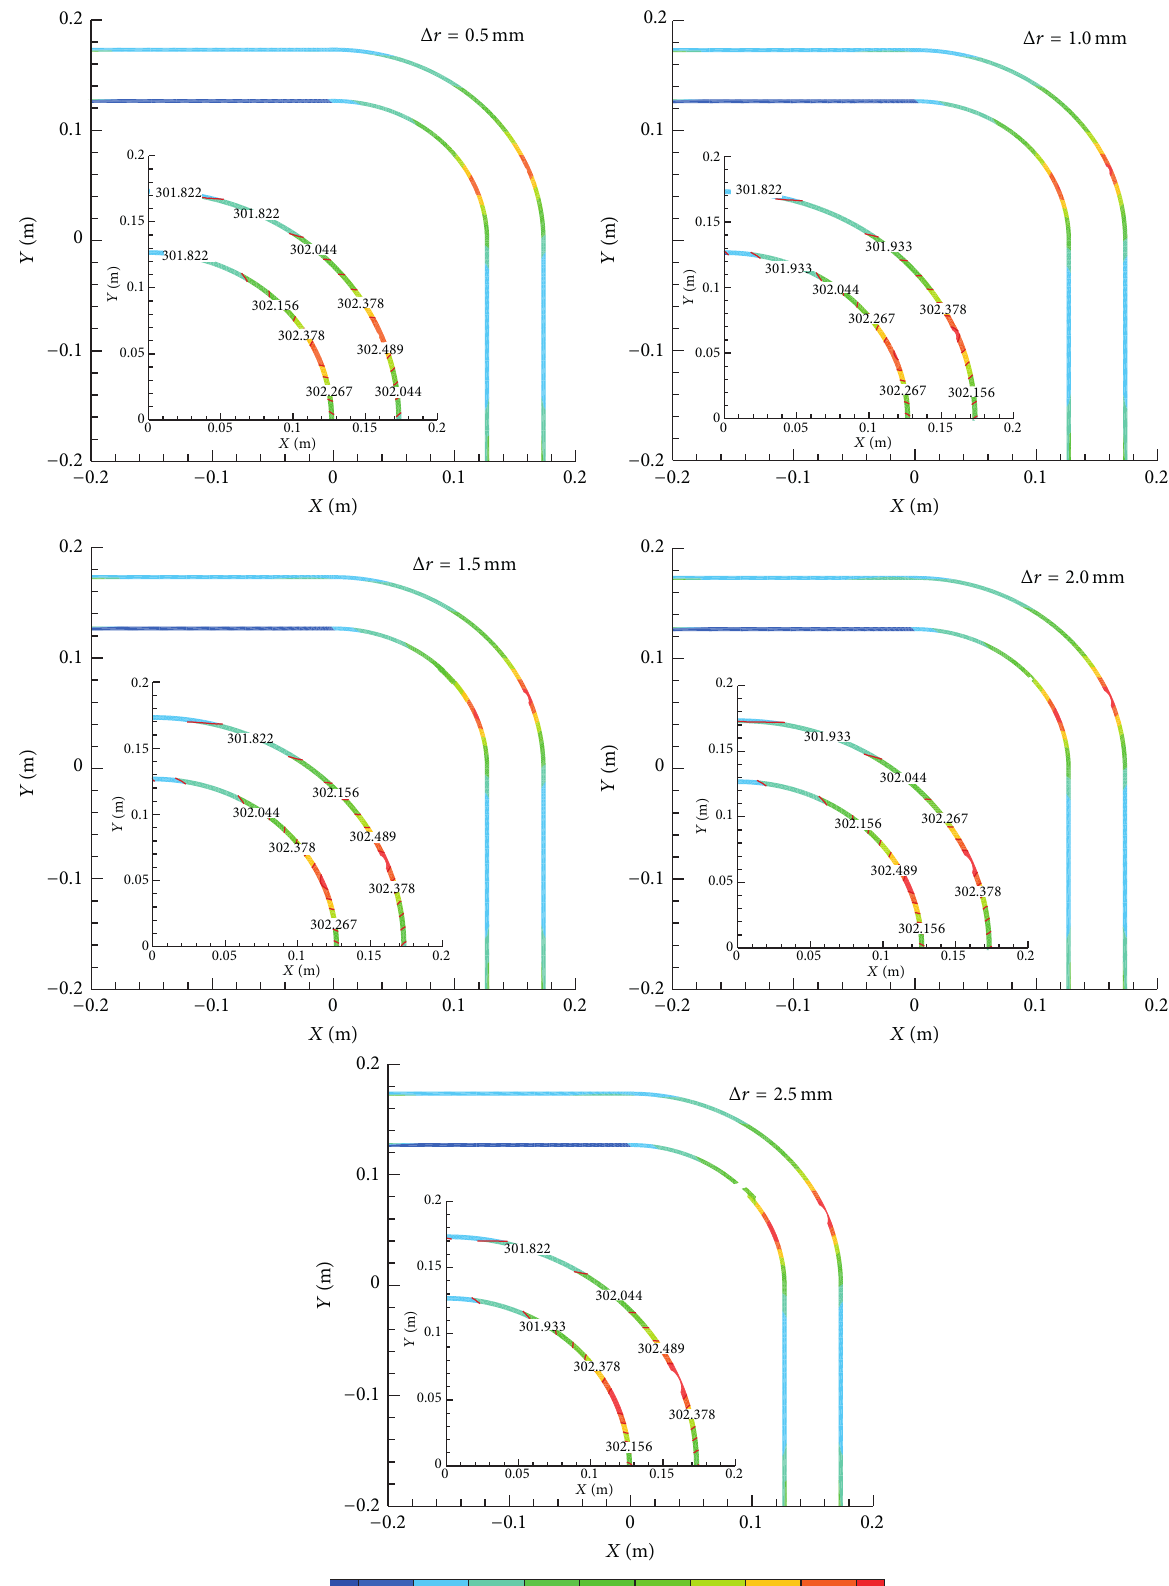
Figure 6: Temperature distribution at the longitudinal cross section of bend pipe at different erosion reduced